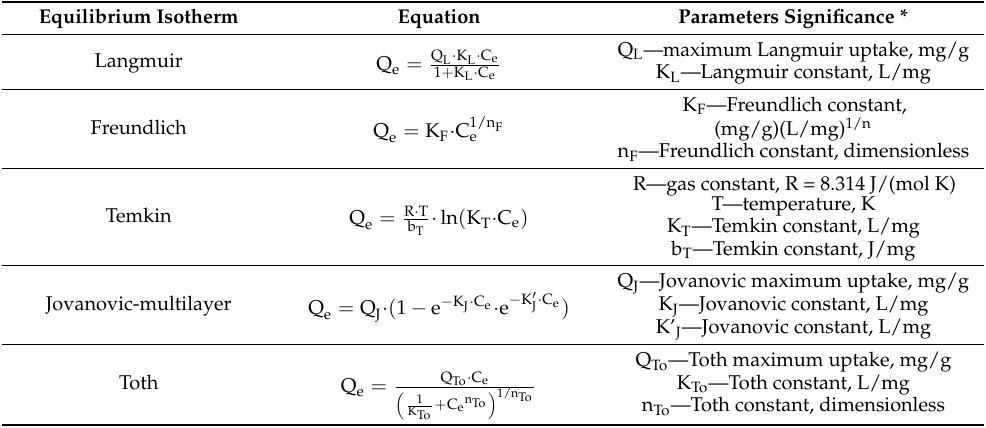
Table 10. Equilibrium isotherms nonlinear